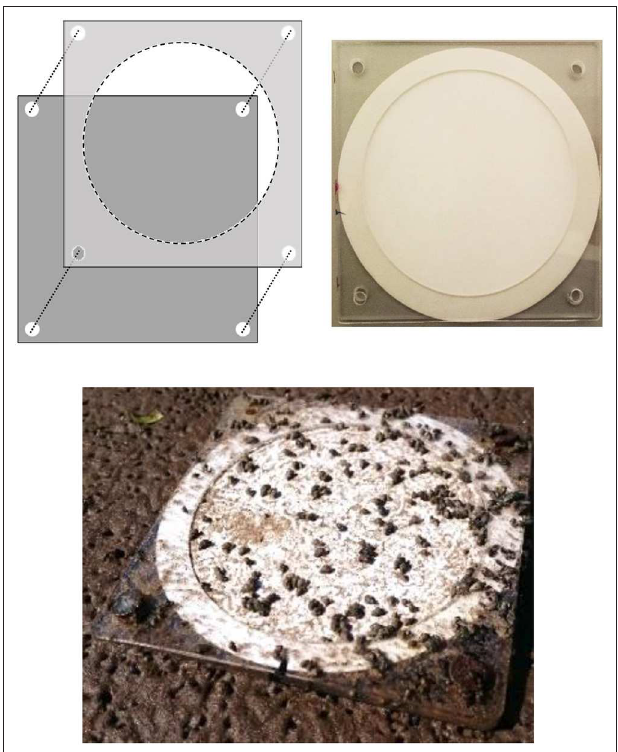
FIGURE 2 | Top left - the deposit trap; upper light gray retention ring holds the filter paper onto the solid dark gray base plate. Four nails are pushed through the corners, affixing to the sediment. Top right - showing trap pre-deployment with filter paper installed. Bottom - showing trap in-situ post exposure with many Hydrobiid snails.